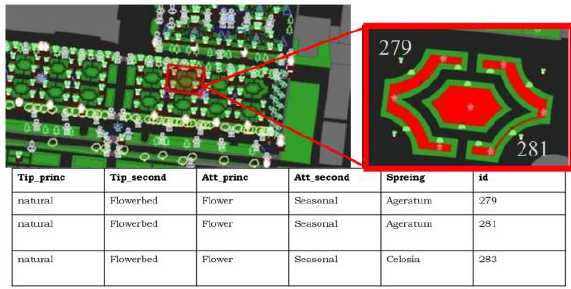
Figure 10. Query selection useful to the gardener to know the type of flowers inside the flowerbed